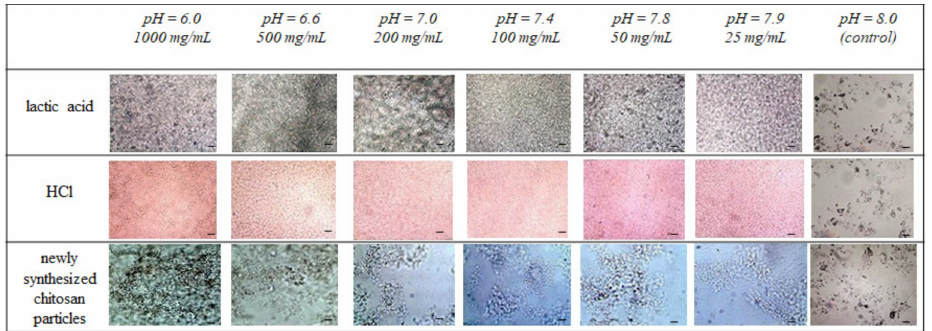
Figure 6. A microscopic photo of the effect of chitosan particles applied in different concentration ranges to colon cancer cells exposed to a forced acidosis cell environment for 48 h (magnification, 40 × ; scale bar, 50 µ